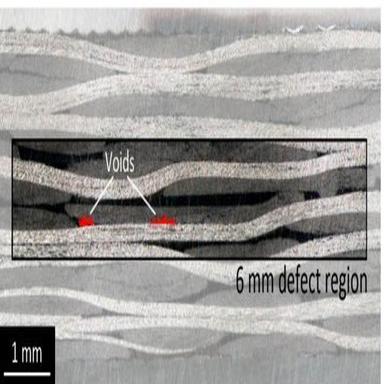
Sub-section from the 1.0 mm slice of the 6 � 6 mm defect specimen.